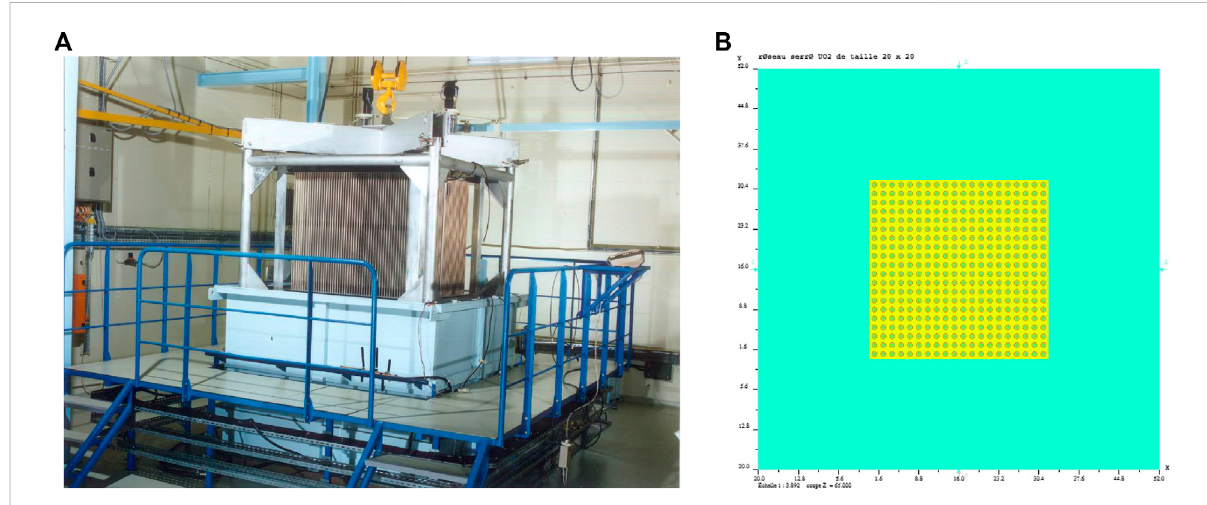
TABLE 1 Primary experiment parameters and uncertainties for LEU-COMP-THERM-071 (Leclaire 2019a). Parameters